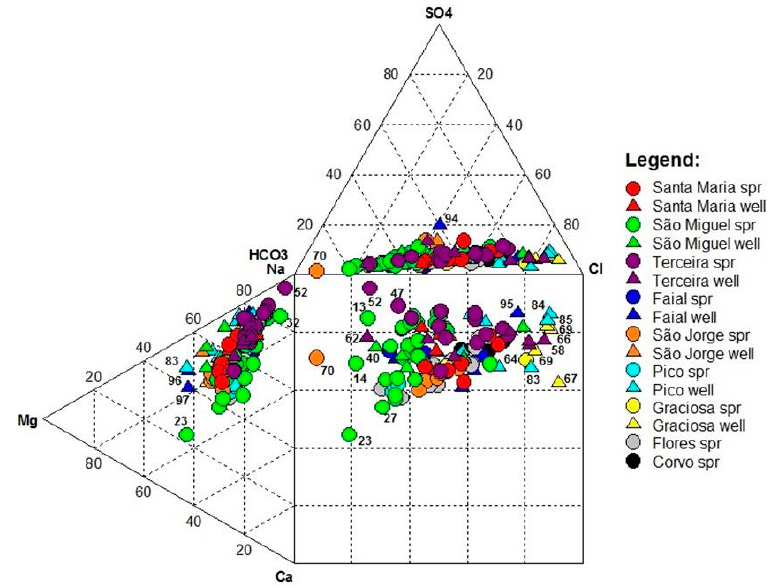
Figure 5. Durov ‐ type diagram depicting major ‐ ion relative composition in studied springs (spr) and wells.